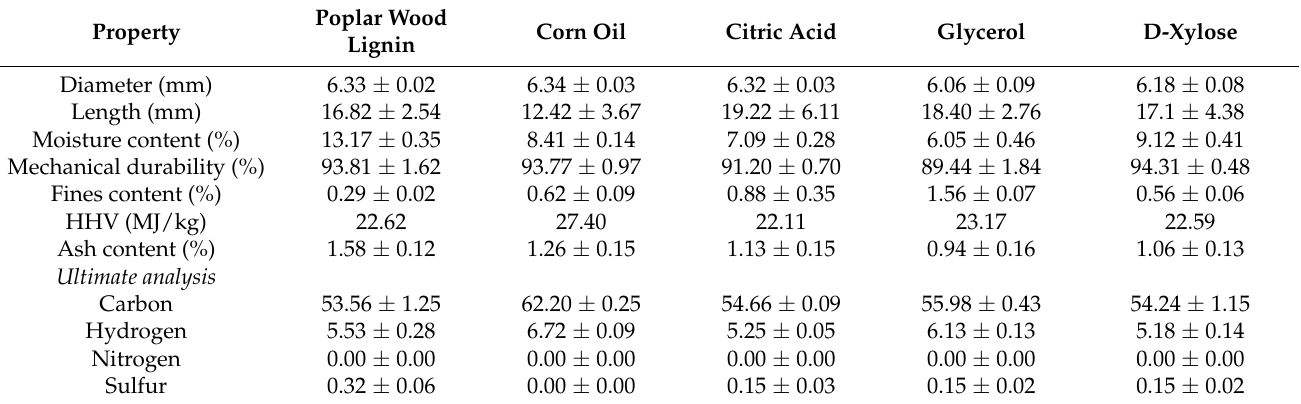
Table 5. Physical and chemical properties for the manufacturing process for pellets manufactured from poplar wood lignin combined with additives (Scenario 2). The results show an average value for 91.0 g of pellets approximately, expressed on dry basis.